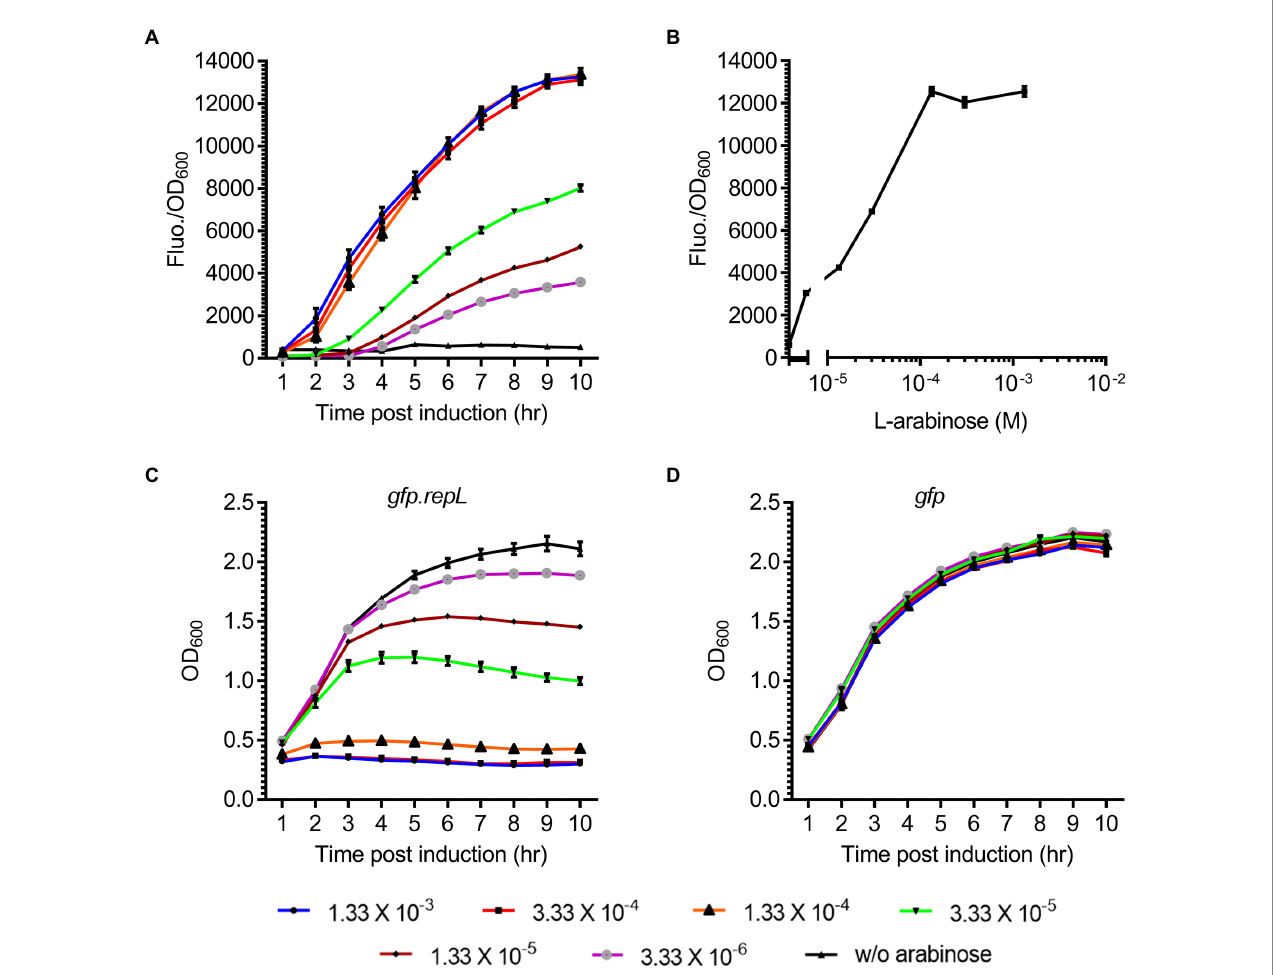
FIGURE 2 Arabinose induction of repL gene expression increased the GFP signal of a reporter plasmid. (A) The GFP fluorescence intensity per OD 600 (FIuo./OD 600 ) of E. coli TOP10 gfp.repL transformants, at 1 to 10 hpi with 3.33 × 10 − 6 M (purple line with gray circles), 1.33 × 10 − 5 M (brown line with black diamonds), 3.33 × 10 − 5 M (green line with black triangles), 1.33 × 10 − 4 M (orange line with black triangles), 3.33 × 10 − 4 M (red line with black squares), 1.33 × 10 − 3 M of L-arabinose (blue line with black circles). GFP FIuo./OD 600 values of uninduced cells (w/o arabinose, in black line with black triangles) were added for comparison purposes. (B) The GFP FIuo./OD 600 of TOP10 transformants at 8 hpi with 3.33 × 10 − 6 M, 1.33 × 10 − 5 M, 3.33 × 10 − 5 M, 1.33 × 10 − 4 M, 3.33 × 10 − 4 M, 1.33 × 10 − 3 M of L-arabinose. (C) The OD 600 of TOP10 gfp.repL transformants and (D) gfp only transformants, at 1 to 10 h PI with 3.33 × 10 − 6 M (purple line with gray circles), 1.33 × 10 − 5 M (brown line with black diamonds), 3.33 × 10 − 5 M (green line with black triangles), 1.33 × 10 − 4 M (orange line with black triangles), 3.33 × 10 − 4 M (red line with black squares), 1.33 × 10 − 3 M of L-arabinose (blue line with black circles). OD 600 values of uninduced cells (w/o arabinose, in black line with black triangles) were added for comparison purposes. All GFP fluorescence intensity were normalized to that of TOP10 cells transformed with an empty plasmid without gfp and repL genes. Induction assays were performed with 3 biological replicates and 4 technical replicates. Data were presented as mean ±